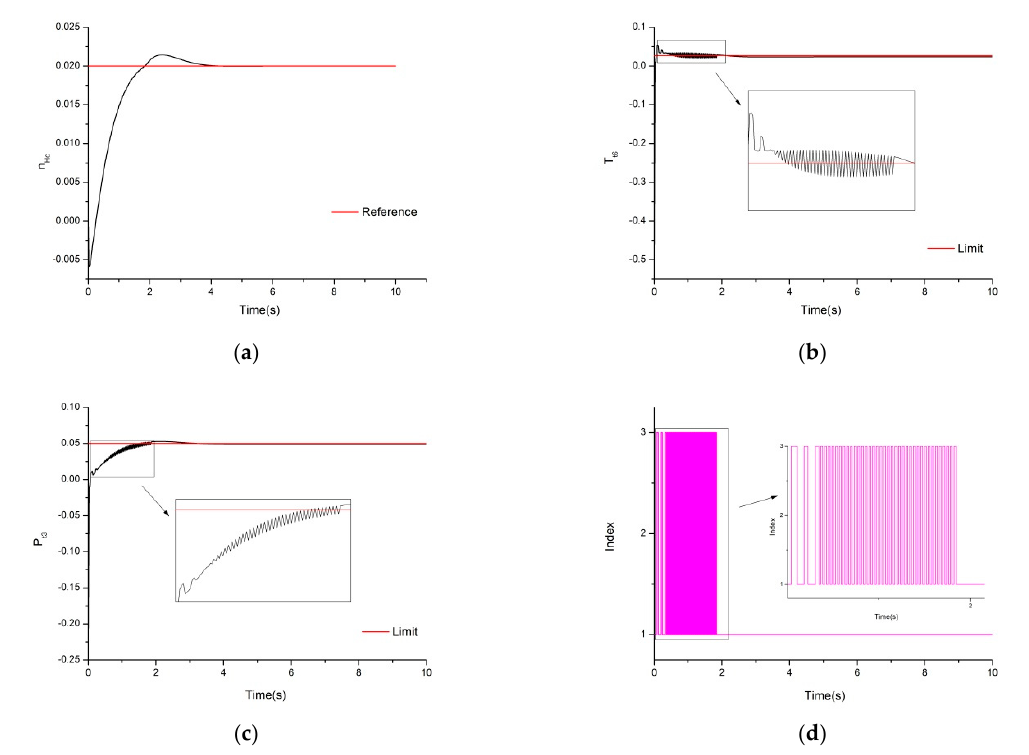
Figure 5. Aero-engine response curves using direct switching method based on output-based switching